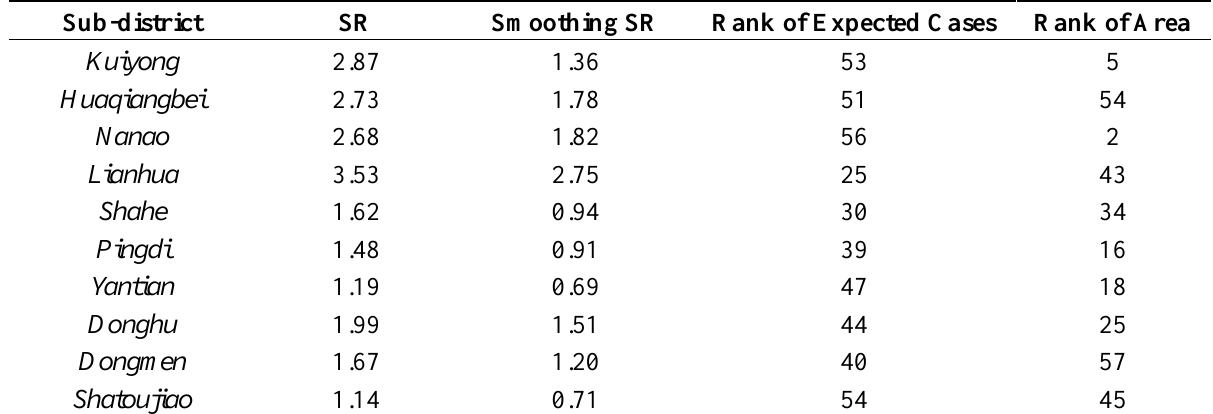
Table 5. A summary of the top ten sub-districts with significant smoothing; the rank is specified from high to